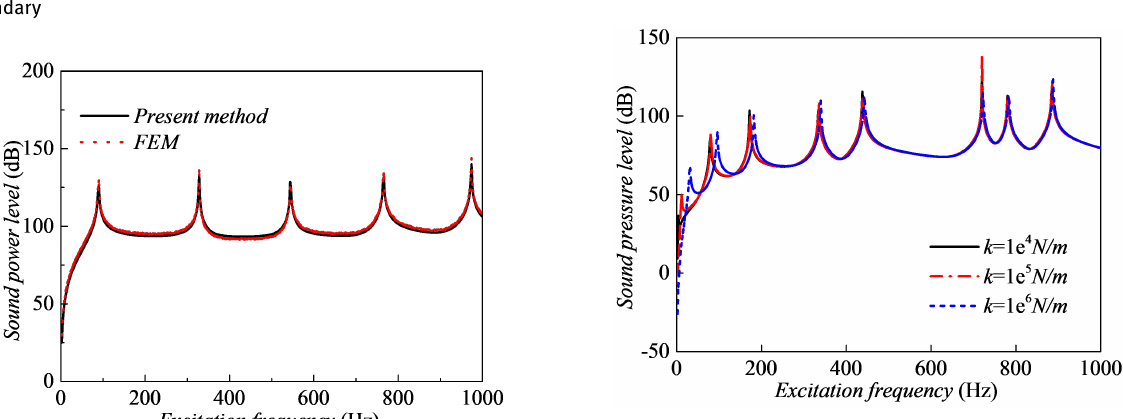
Figure 12: Sound power level with different boundary conditions